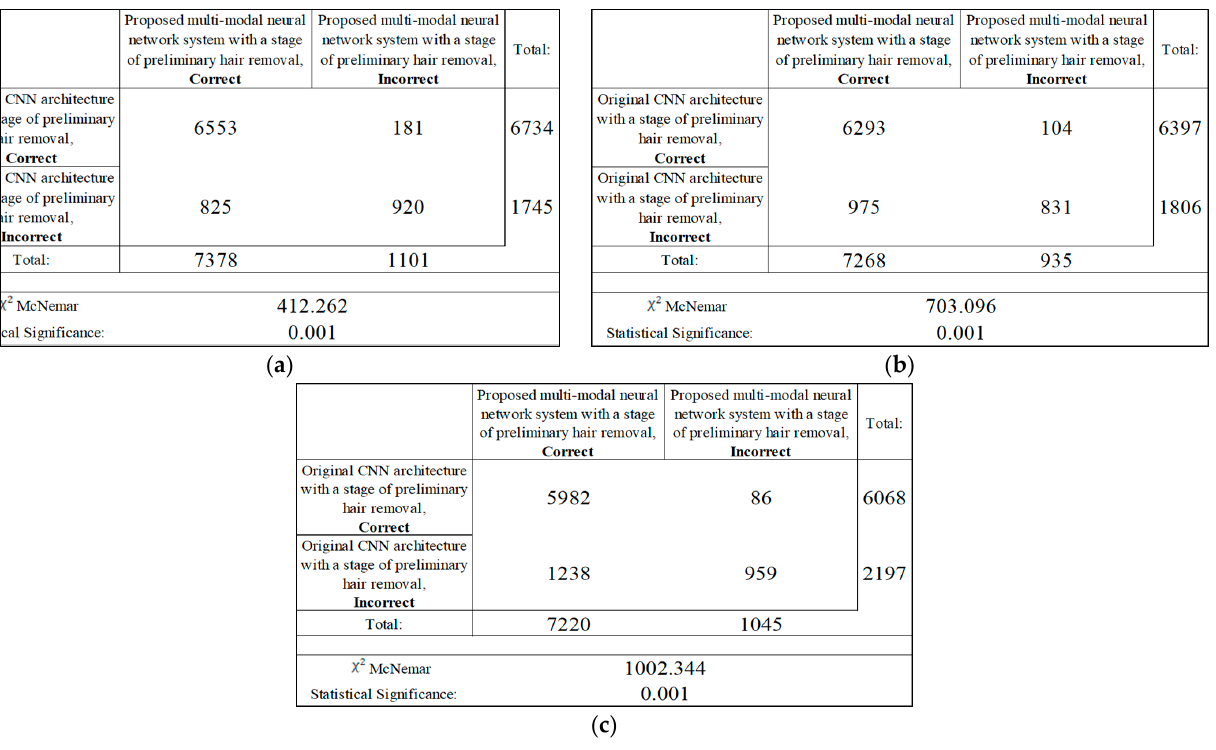
Figure 17. Classification table neural network systems for recognizing pigmented skin lesions for analysis McNemar based on CNN: ( a ) AlexNet; ( b ) SqueezeNet; ( c ) ResNet ‐ 101.